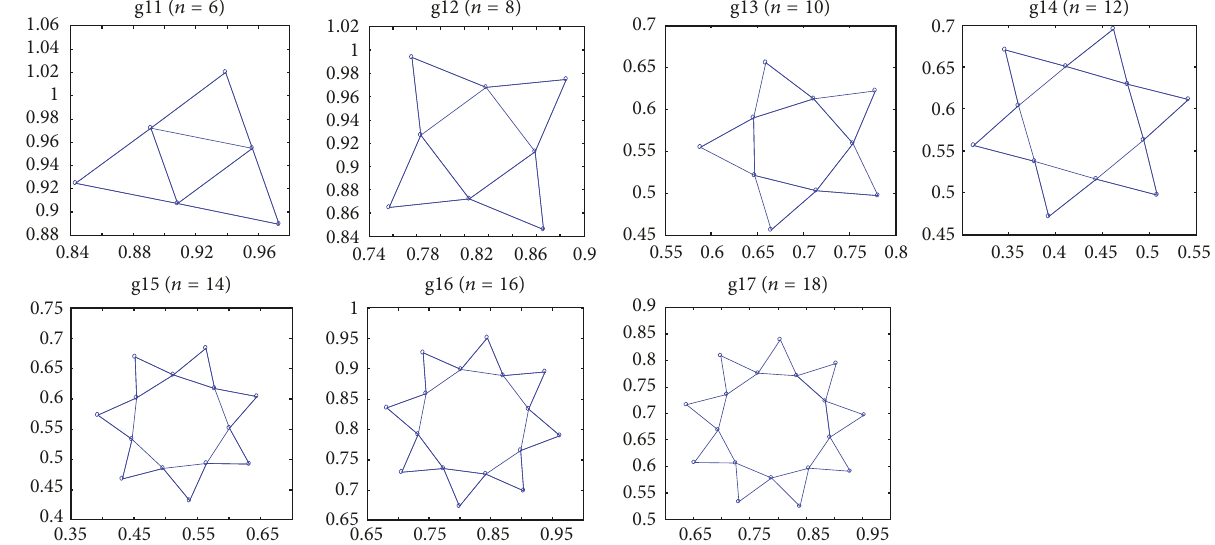
Figure 6: Layouts of seven graphs (g11–g17) in Group 1 with different numbers of vertices.